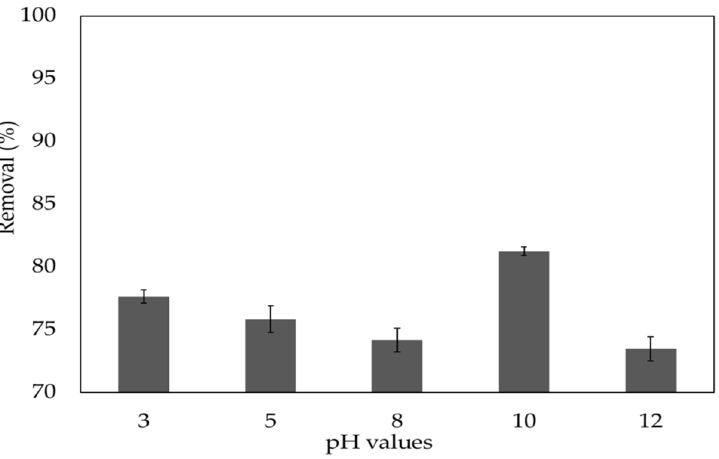
Figure 5. Impact of the initial pH on removal efficiency of methylene blue dye.